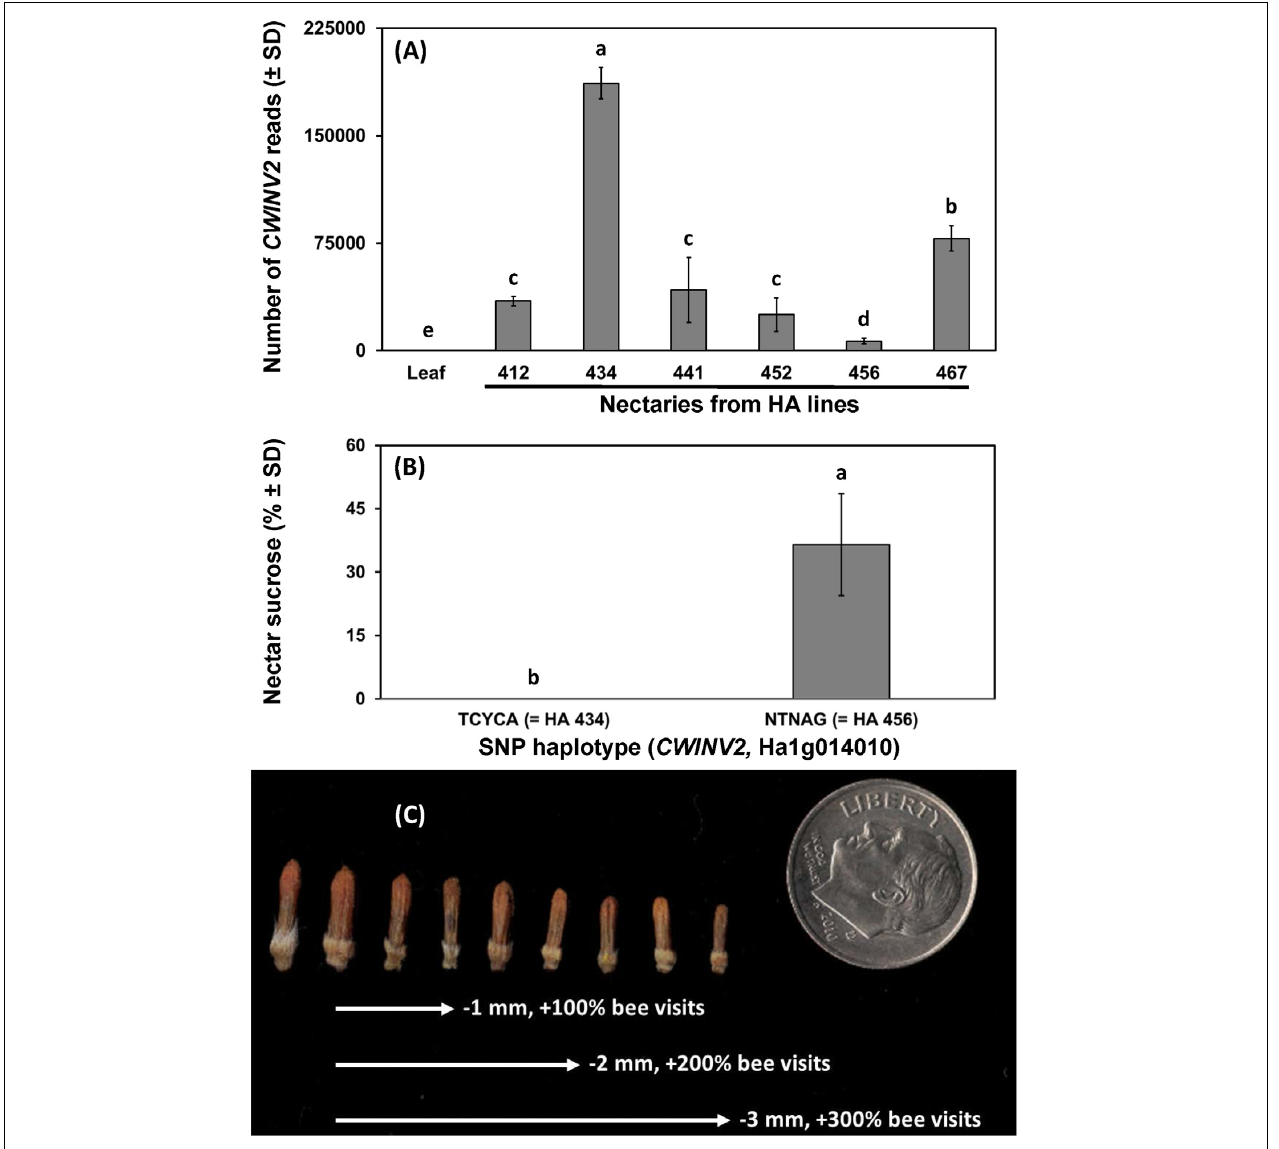
FIGURE 1 | Relationships between nectar-related traits in sunflower and genetic markers or pollinator behavior. Panels indicate (A) expression of cell wall invertase ( CWINV2 ) from control tissue (leaf) and nectaries of Helianthus annuus maintainer (HA) lines previously phenotyped for sucrose content, (B) sucrose content (% by mass of sucrose + fructose + glucose) of nectars associated with two SNP haplotypes at CWINV2 ( n = 10 inbred lines per group), and (C) illustration of the range of floret sizes in cultivated sunflowers and the effect of decreasing floret size (from start to end of arrows) on visitation by wild bees as observed by Portlas et al. (2018). Significant differences between pairs in (A,B) indicated by differing lowercase